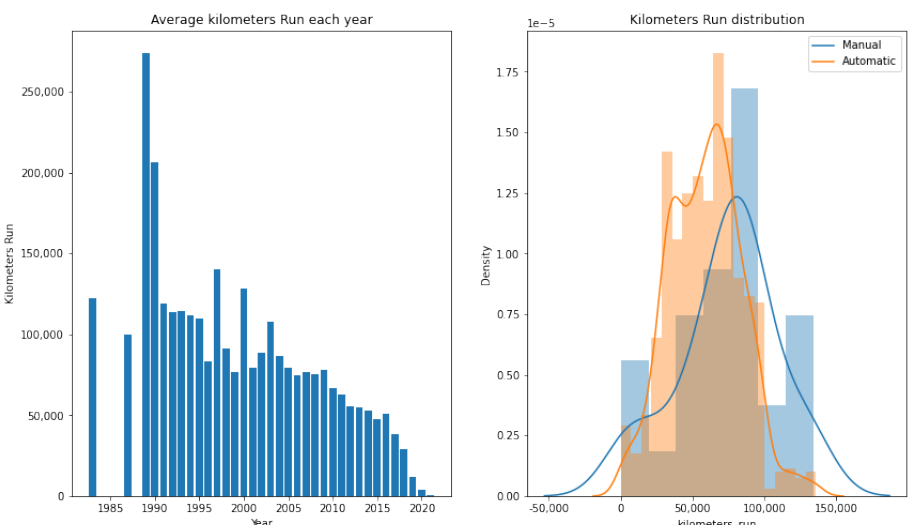
Figure 14. Average kilometers_run for each model_year and their distribution